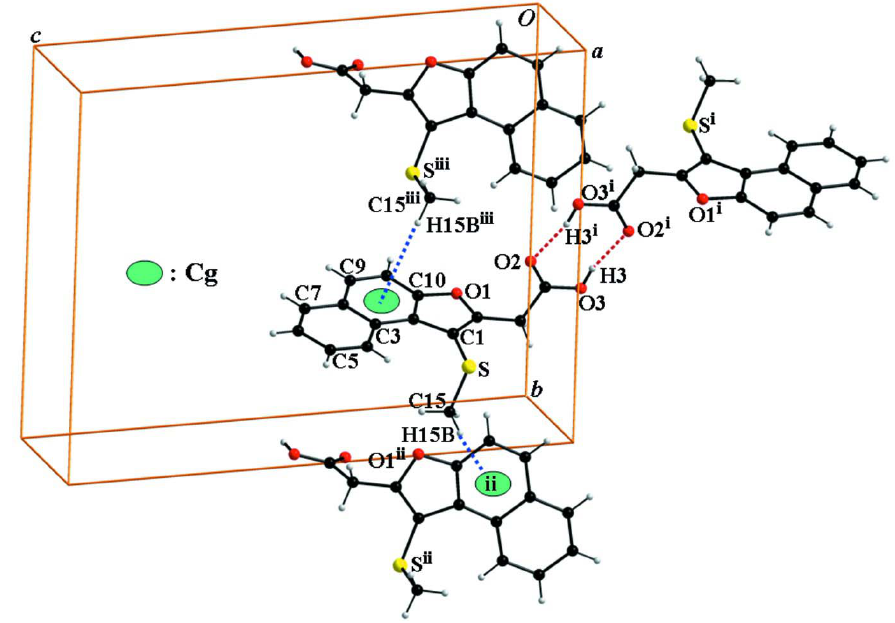
Figure 2 The C–H··· π interaction and O–H···O hydrogen bond (dotted lines) in the title compound. Cg denotes ring centroids. [Symmetry code: (i) - x + 2, - y + 1, - z ; (ii) - x + 3/2, y + 1/2, - z + 1/2; (iii) - x + 3/2, y - 1/2, - z +